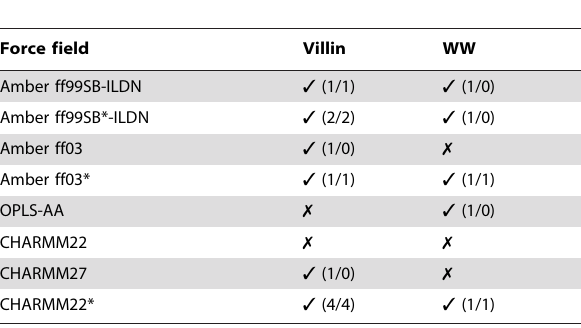
Table 1. Evaluating force fields by folding